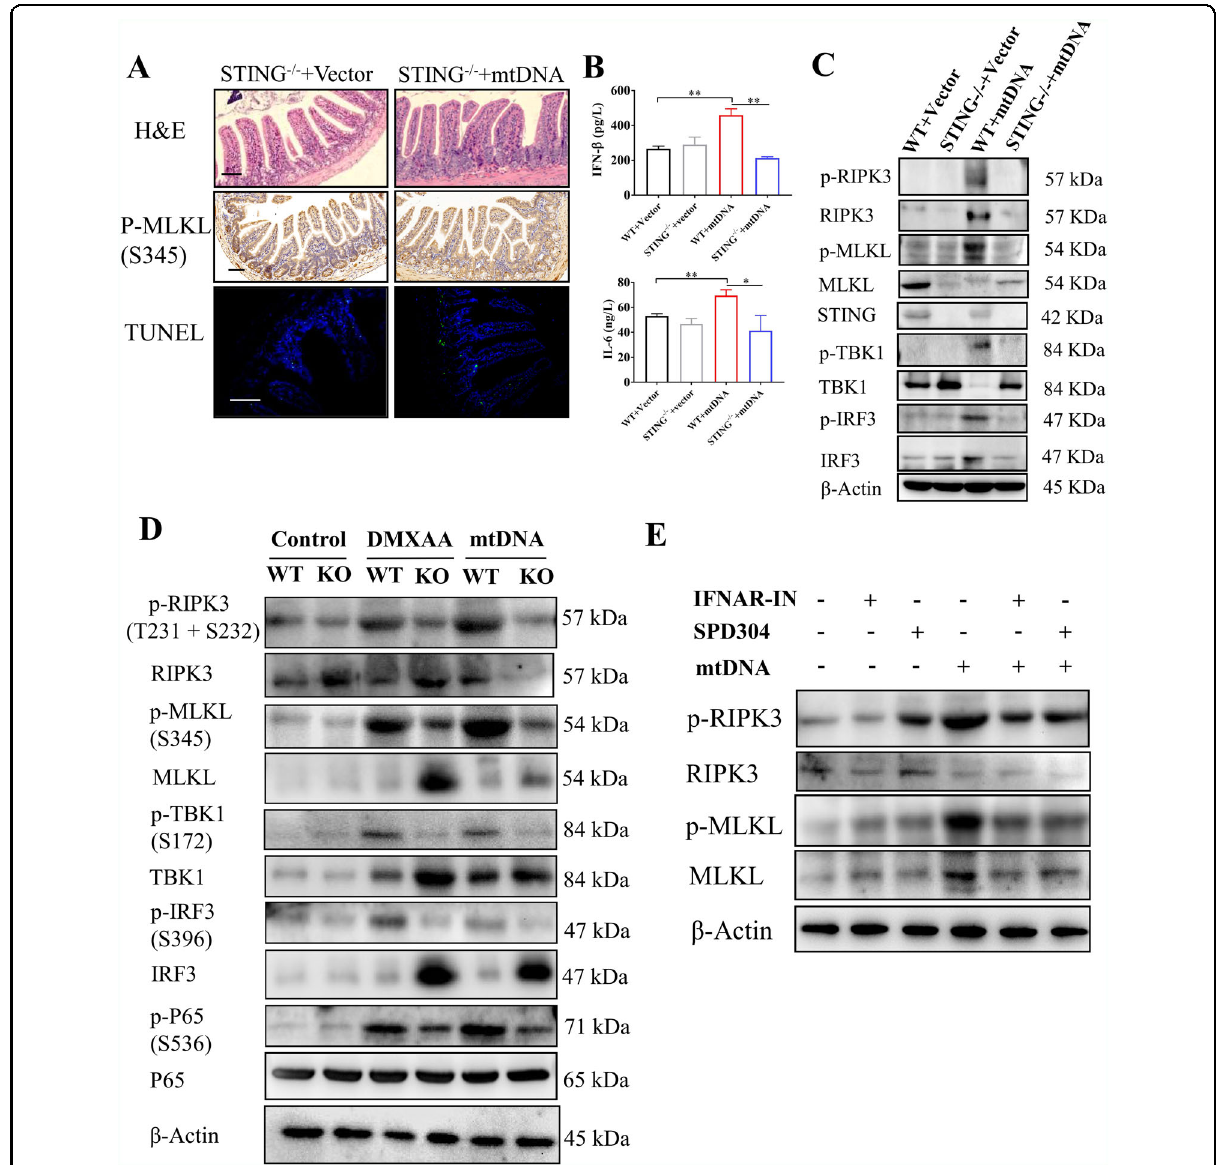
Fig. 3 STING signaling promotes mtDNA-mediated necroptosis. ( A ) Representative images of intestinal H&E, IHC (p-MLKL), and TUNEL staining in STING knockout mice after the intraperitoneal injection of mtDNA. ( B ) Plasma IFN- β and IL-6 were tested by ELISA. ( C ) STING signaling and necroptosis were analyzed by western blot. ( D ) Primary intestinal epithelial cells (IECs) isolated from wild-type or STING knockout mice were stimulated with 50 μ g/ml DMXAA or 10 μ g/ml mtDNA. Western blot was used to analyze STING and necroptosis signaling. ( E ) Primary IECs were treated with 10 μ g/ml mtDNA, 1 μ M IFN alpha-IFNAR-IN-1 (IFNAR-IN) or 2 μ M SPD304. Western blot was used to analyze necroptosis signaling. Scale bars = 50 μ m. Data were shown as the mean ± SD. * P < 0.05, ** P < 0.01, *** P <